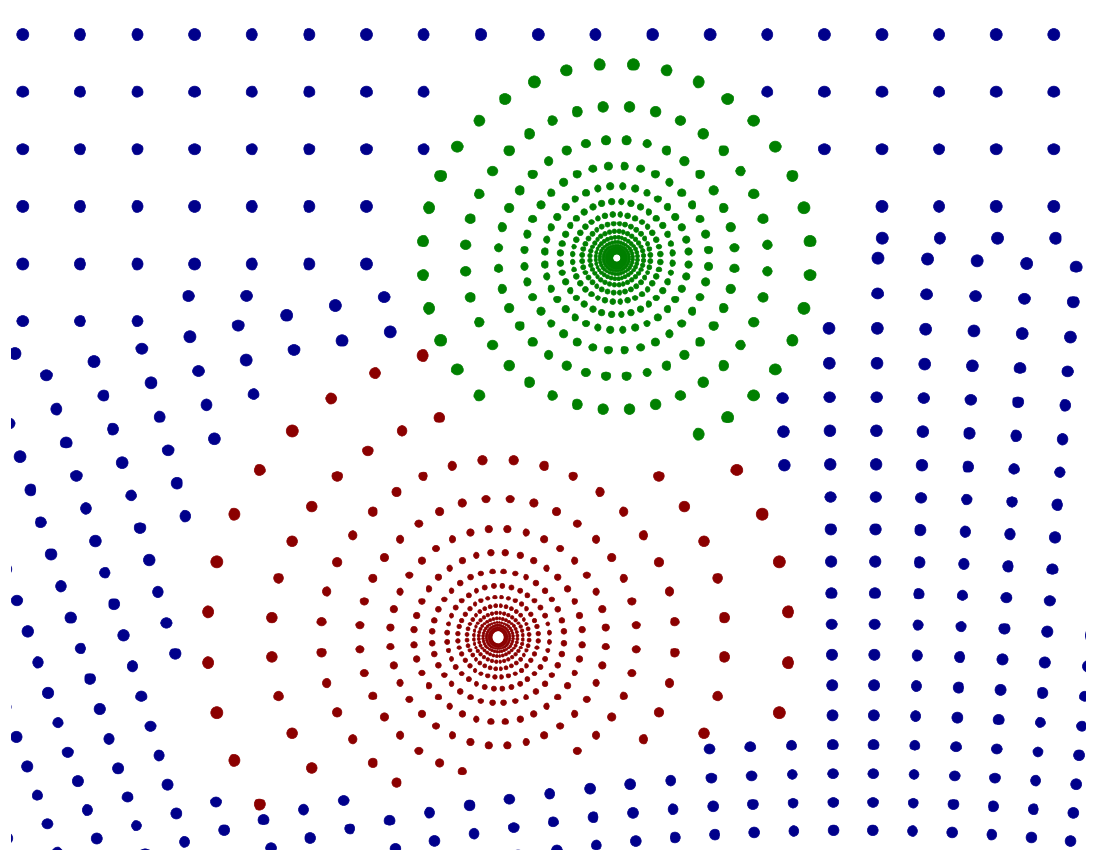
Figure 4. Formation of a single cloud from nodes belonging to different domains.